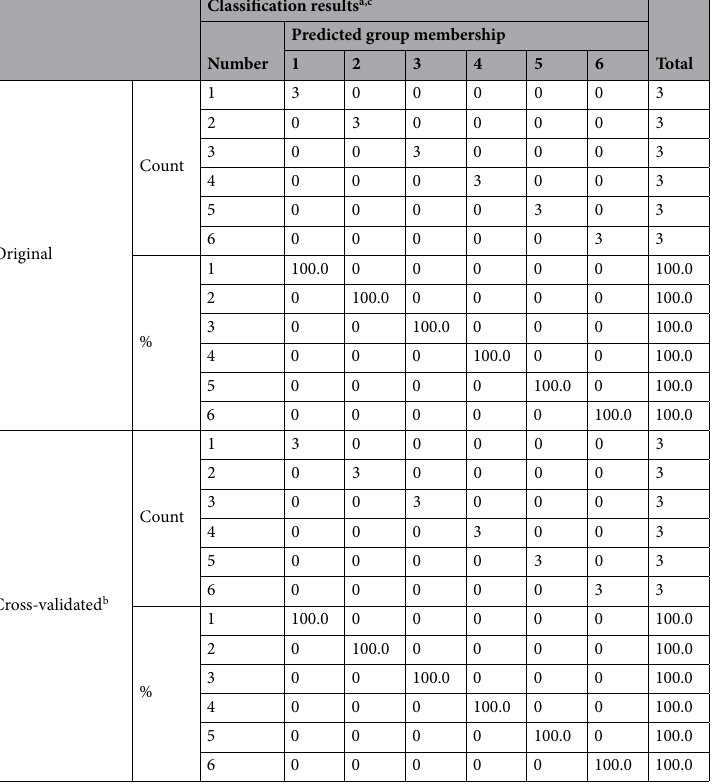
Table 1. Discrimination results of samples. a 100.0% of original grouped cases are correctly classified. b Cross validation is done only for those cases in the analysis. In cross validation, each case is classified by the functions derived from all cases other than that case. c 100.0% of cross-validated grouped cases are correctly classified. 1